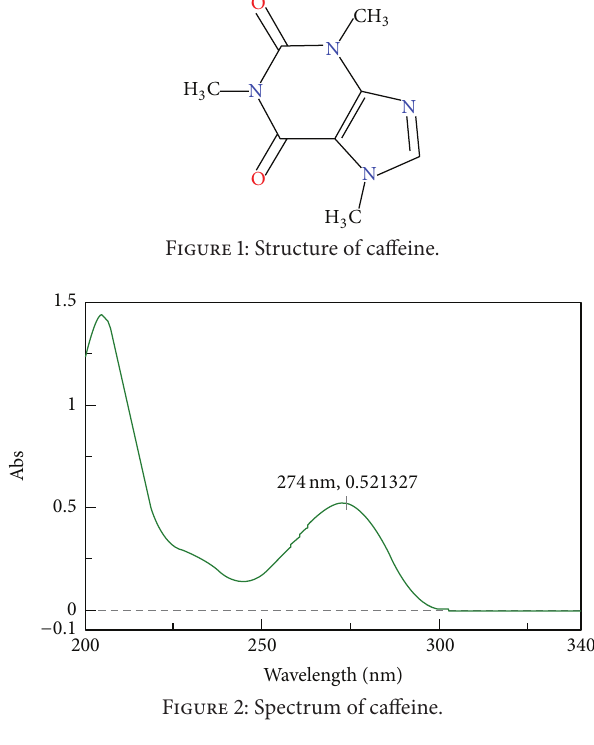
Figure 2: Spectrum of